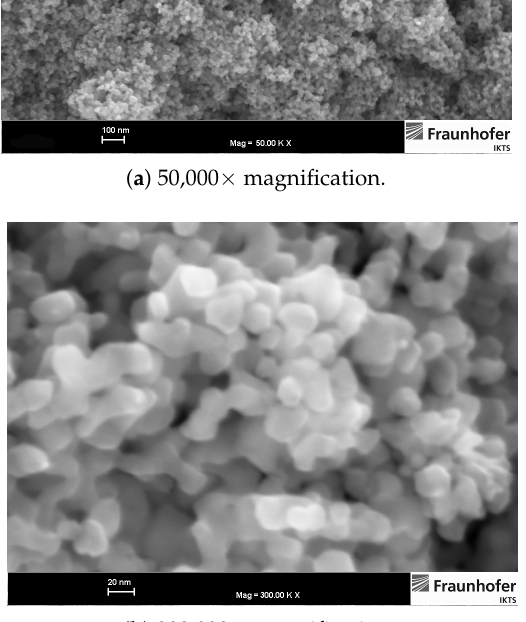
Figure 2. ITO powder, FESEM images of powder surface at two different magnifications.